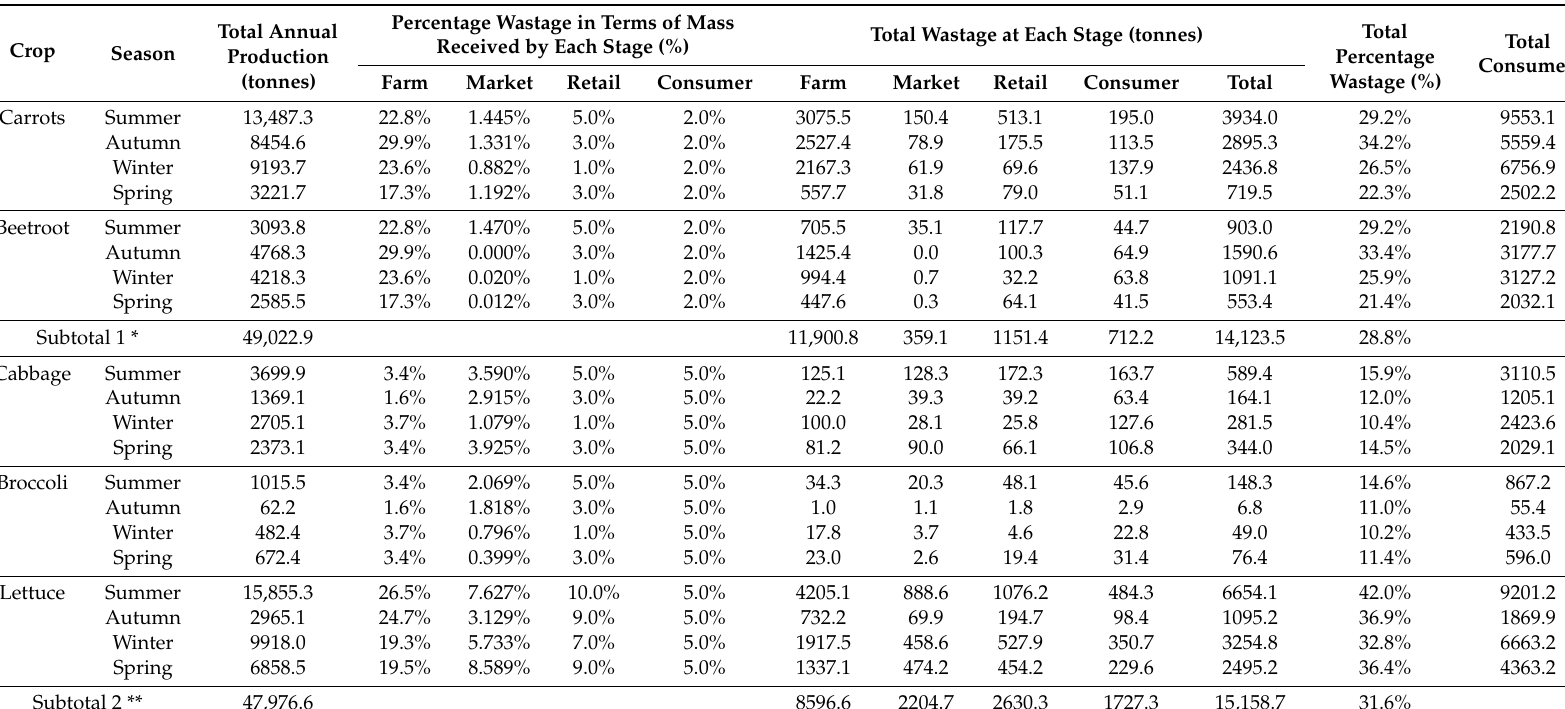
Table 1. Summary of wastage of carrots, cabbage, beetroot, broccoli and lettuce along the supply chain from the farm to the consumer in terms of total production on the Steenkoppies Aquifer in